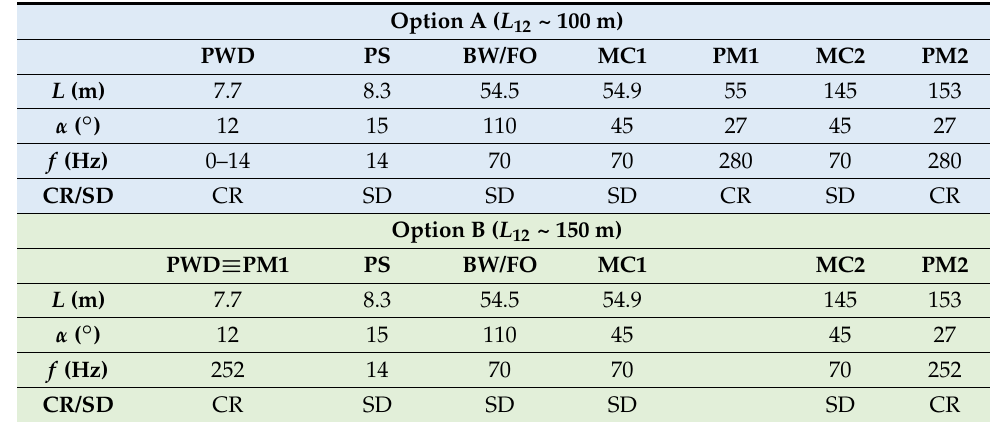
Table 1. Main parameters (location, L , slit size, a, frequency, f , and whether the chopper is a counter rotating double disk (CR) or single disk (SD)) for the proposed chopper layouts for pulse multiplication in MIRACLES using two fast choppers. PWD, PS, and BW/FO choppers correspond to the current chopper cascade of